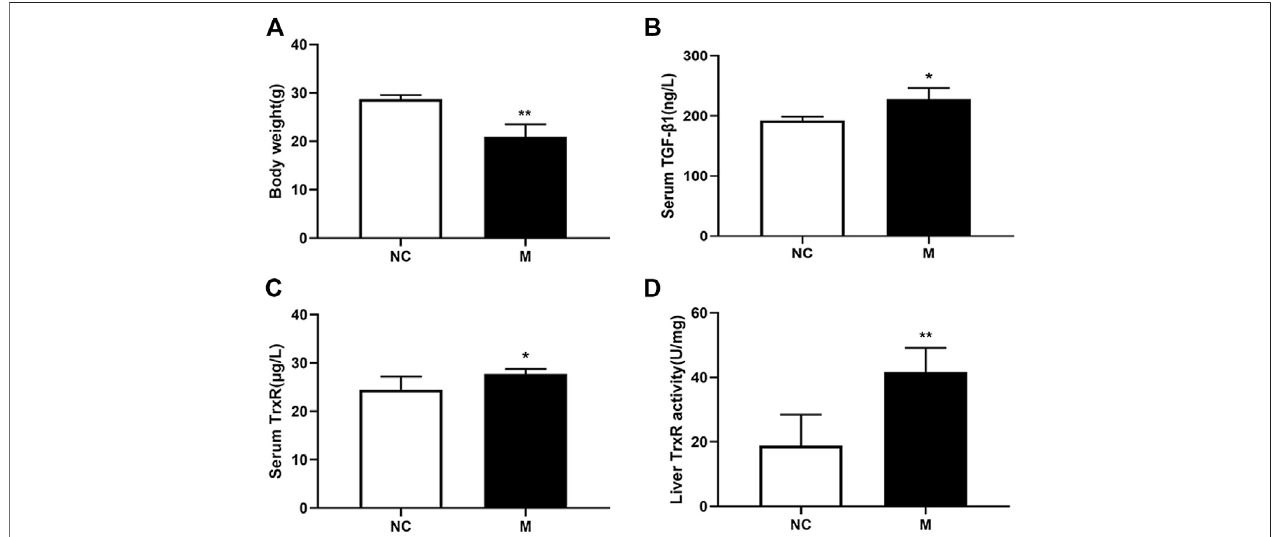
FIGURE 1 | CCl 4 affected the levels of body weights, TrxR, and TGF- β 1 in mouse liver fi brosis models. (A) Body weights. (B, C) The levels of the liver and serum TrxR were analyzed by ELISA. (D) The level of serum TGF- β 1 was analyzed by ELISA. Data were shown as mean ± SD, n ≥ 3 and analyzed with two-tailed Student ’ s t-test. * p < 0.05 and ** p < 0.01 in the model group versus the control